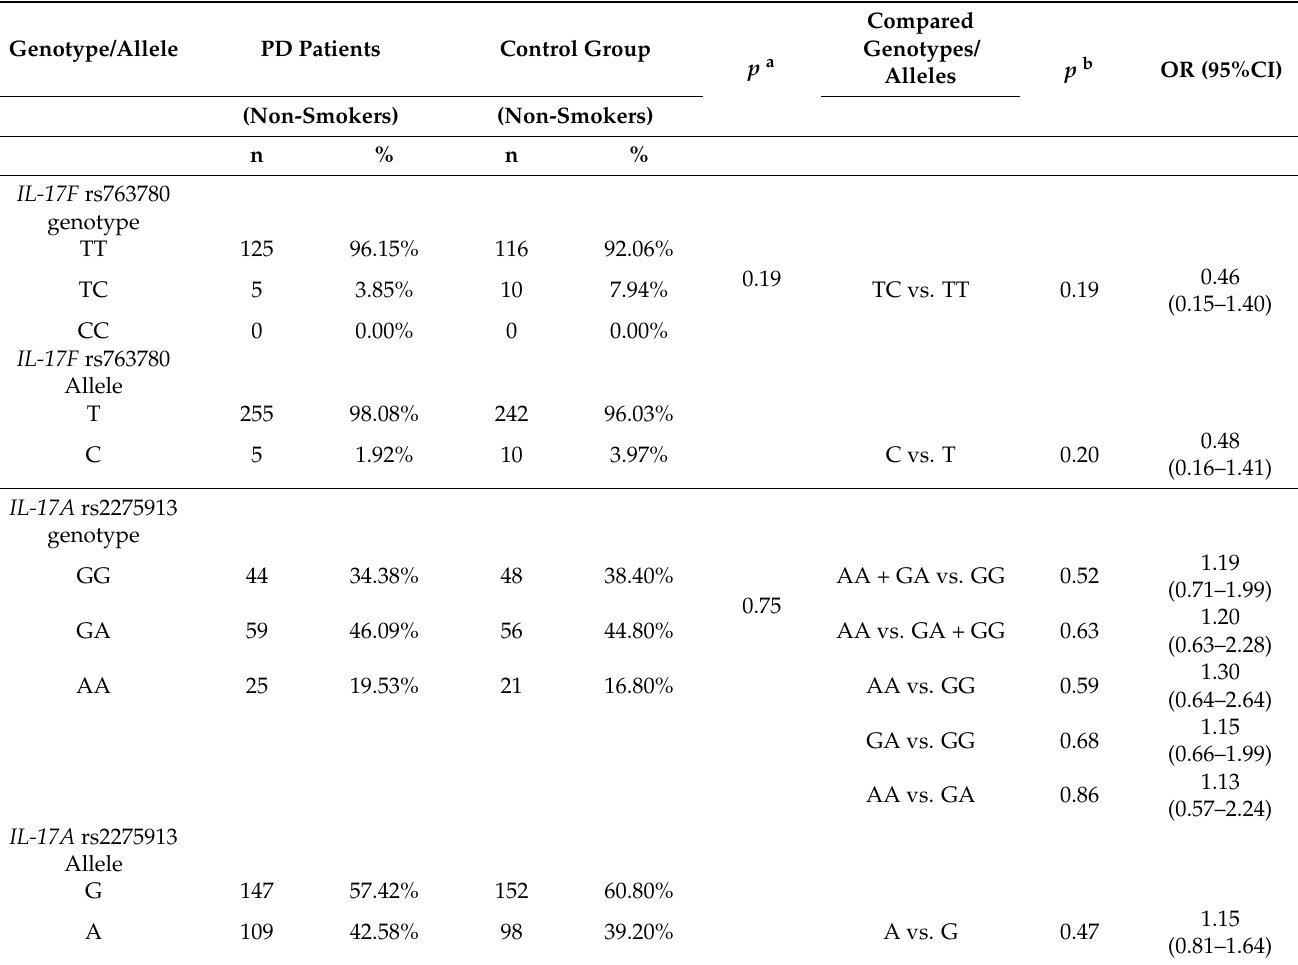
Table 3. The distribution of IL-17F rs763780 and IL-17A rs2275913 genotypes in periodontitis patients and control group in non-smokers group.